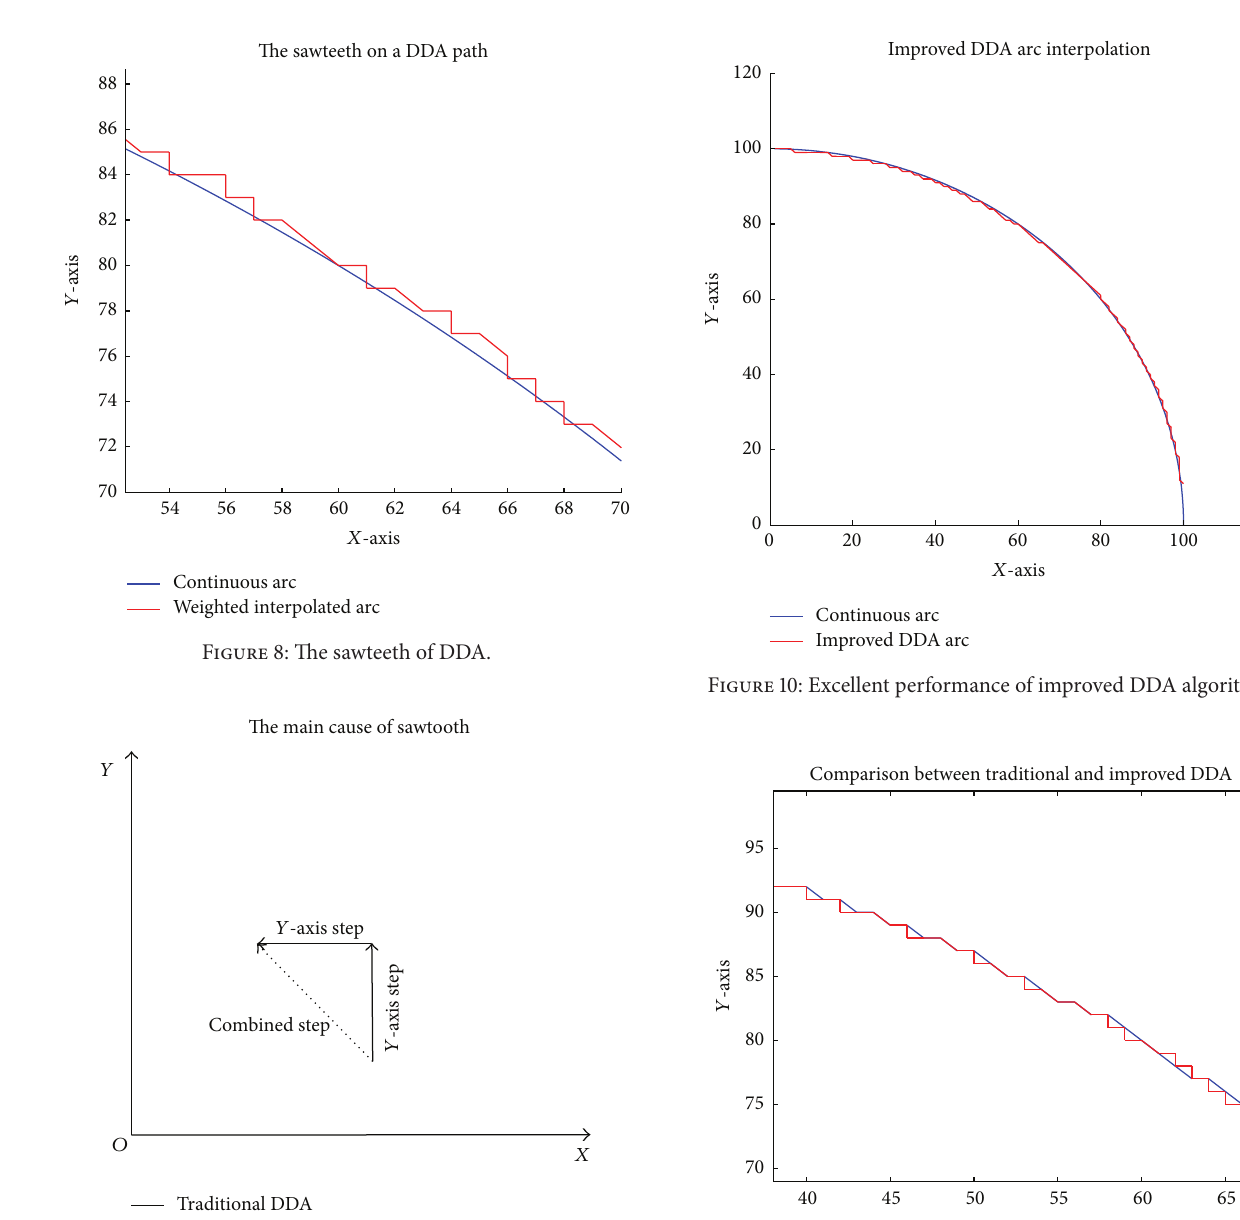
Figure 9: Sawtooth along the arc path.